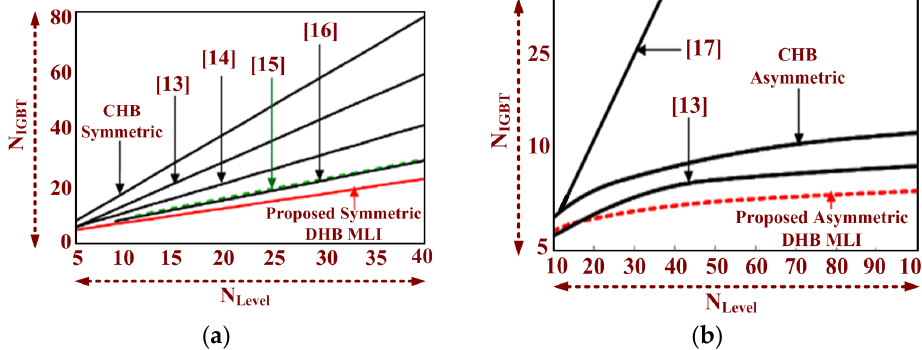
Figure 4. Comparison of N IGBT versus N Level for the proposed topologies with other recent MLI topologies ( a ) Symmetric DHB, ( b ) Asymmetric DHB.